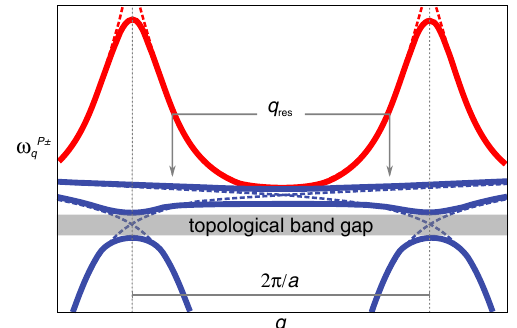
FIG. 5. Scheme for opening a topological gap using a periodic potential. The solid (dashed) blue and red lines correspond to the dispersion of the lower and upper polaritons with (without) a periodic potential in a simplified one-dimensional scenario. As long as π =a > q , the lowest polariton band includes the res winding around the resonance and the gap opened at the Brillouin-zone boundary is of topological